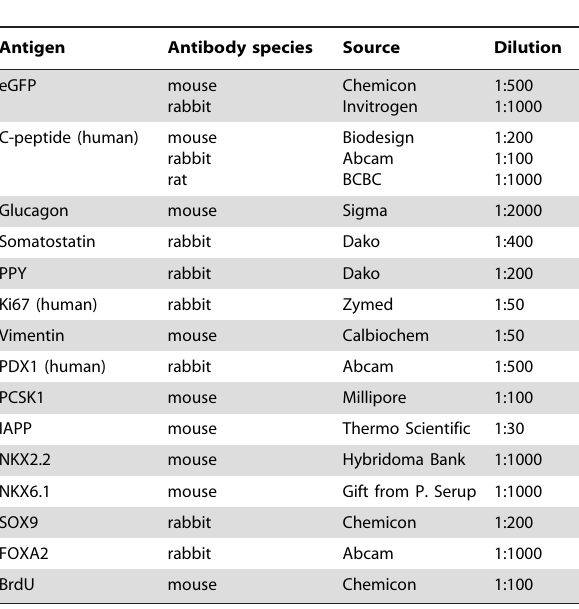
Table 3. Antibodies used in